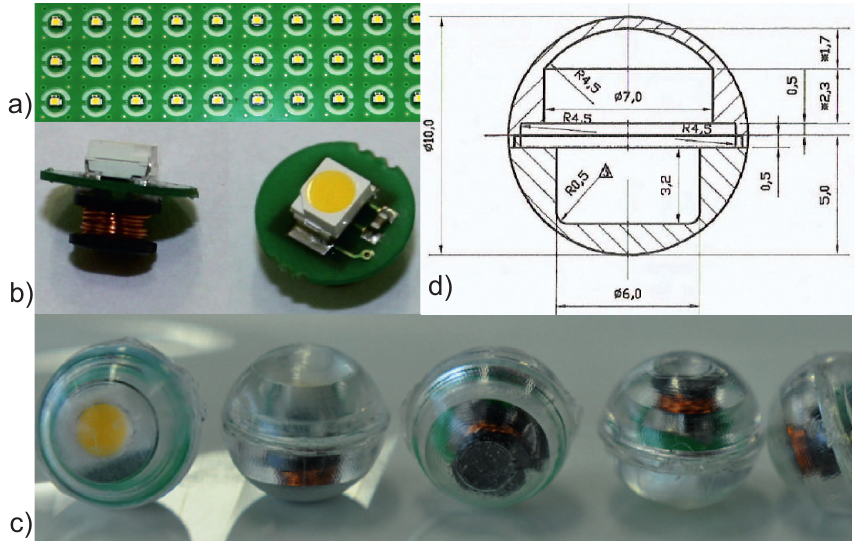
Figure 1. ( a ) series production on professional PCB board; ( b ) close-up of side view and top view; ( c ) encapsulated Wireless Light Emitters (WLE); ( d ) construction